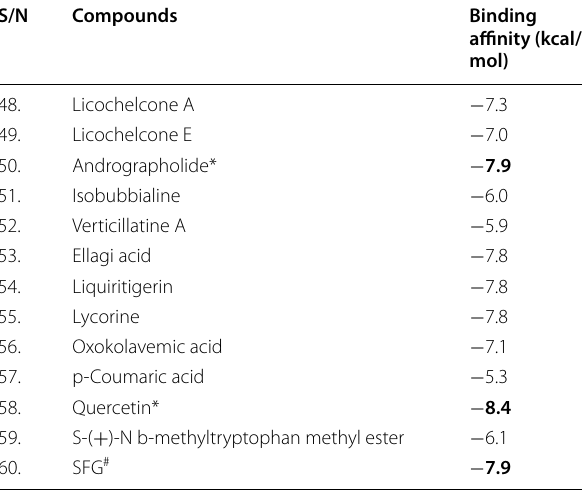
Table 2 Binding affinity of compounds from antiviral